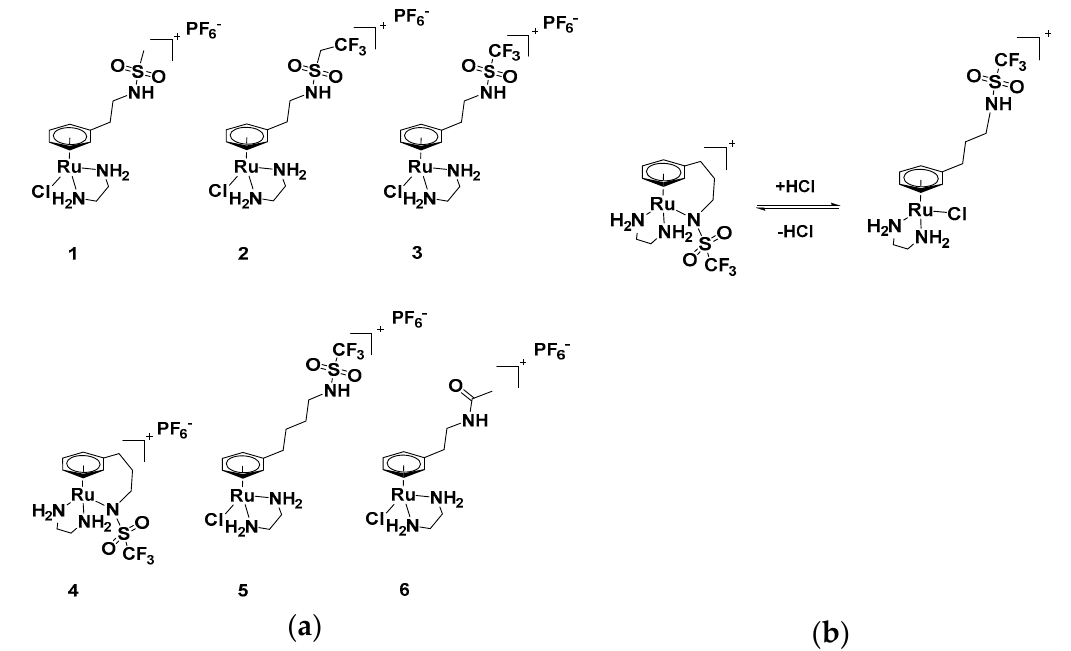
Figure 2. ( a ) Compounds 1 – 6 ; ( b ) Reversible pH-dependent intramolecular sulfonamide ligation with 4